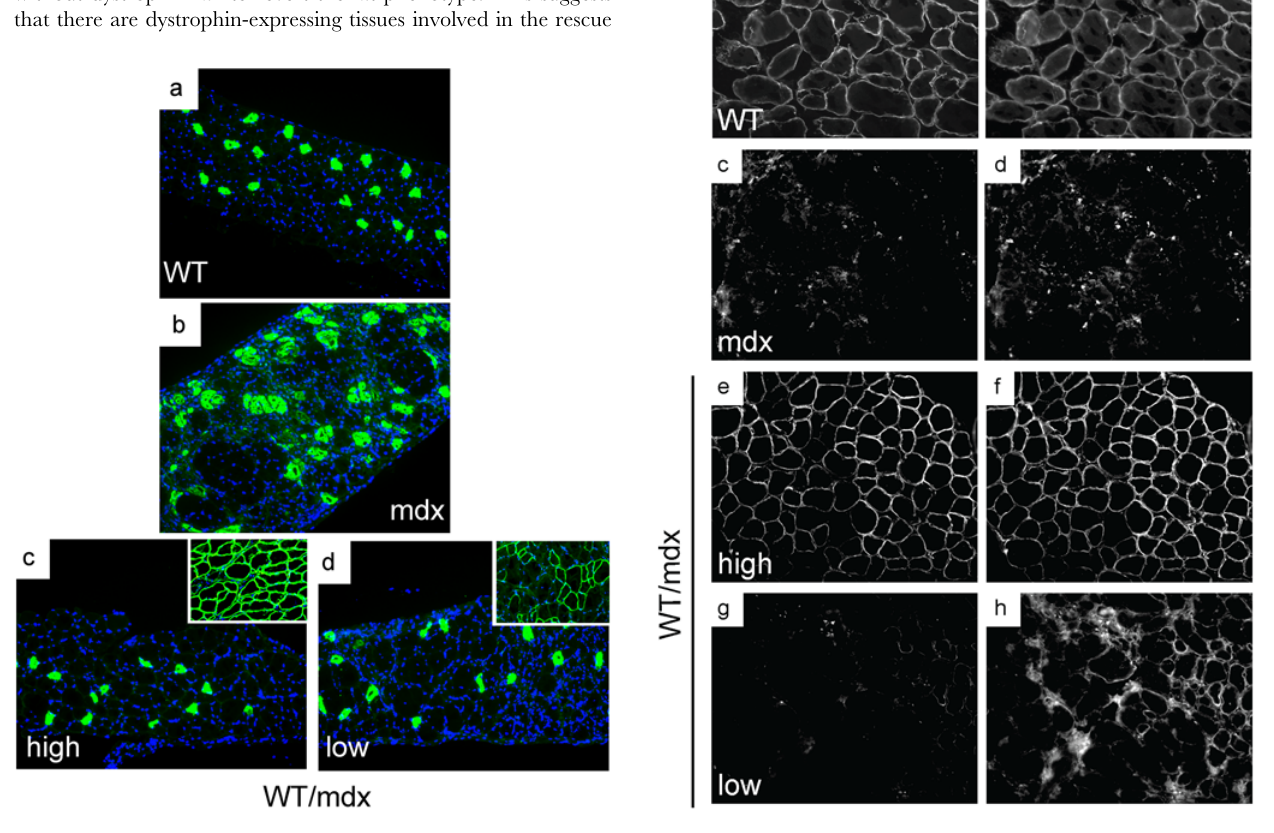
Figure 9. Dystrobrevin is present in areas with low dystrophin in WT/mdx muscle. a–h, diaphragms from WT (a, b), mdx (c, d), and 10–30% WT/mdx (e–h) were sectioned and stained for dystrophin (a, c, e, g) and dystrobrevin (b, d, f, h). e–h, areas with high dystrophin (e, f) and areas with low dystrophin (g, h) within the same muscle. Magnification: 200 6 . Experiments were performed with pectoralis and diaphragm muscles of 3 animals (n=3) per group (WT, mdx and 10– 30%